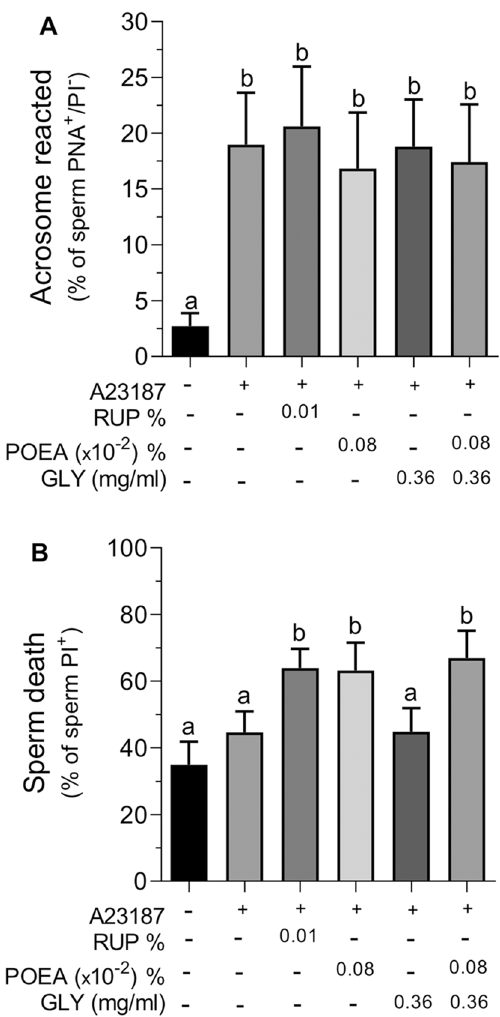
Figure 5. Effects of Roundup Ultra Plus (RUP), glyphosate (GLY) and surfactant polyoxyethylene tallow amine (POEA) on acrosome membrane damaged ( A ) and cell death ( B ) after A23187 treatment in human spermatozoa. Spermatozoa were incubated in BWW for 1 h at 37 °C, 5% CO 2 , in the absence or presence of indicated concentrations of RUP, POEA, GLY or POEA in combination with GLY. This experiment was performed 7 times (n = 7) and the results were expressed as the mean of the percentage of PNA-positive and PI-negative spermatozoa ± standard error of the mean (SEM). Columns with different letters are statistically different from each other, so that for P <